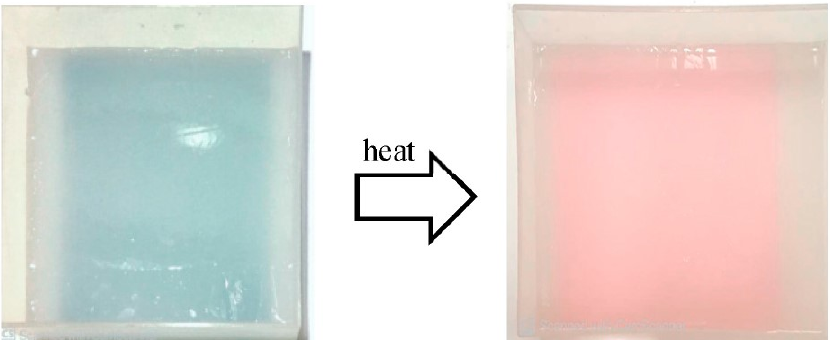
Figure 2. ( left ): PDA-Phytagel after 6 MV X-ray irradiation with absorbed dose of 20 Gy in reference conditions (field size 10 × 10 cm 2 , SSD 100 cm), the PDA is in its blue phase; ( right ): the sample after heating, the PDA turned